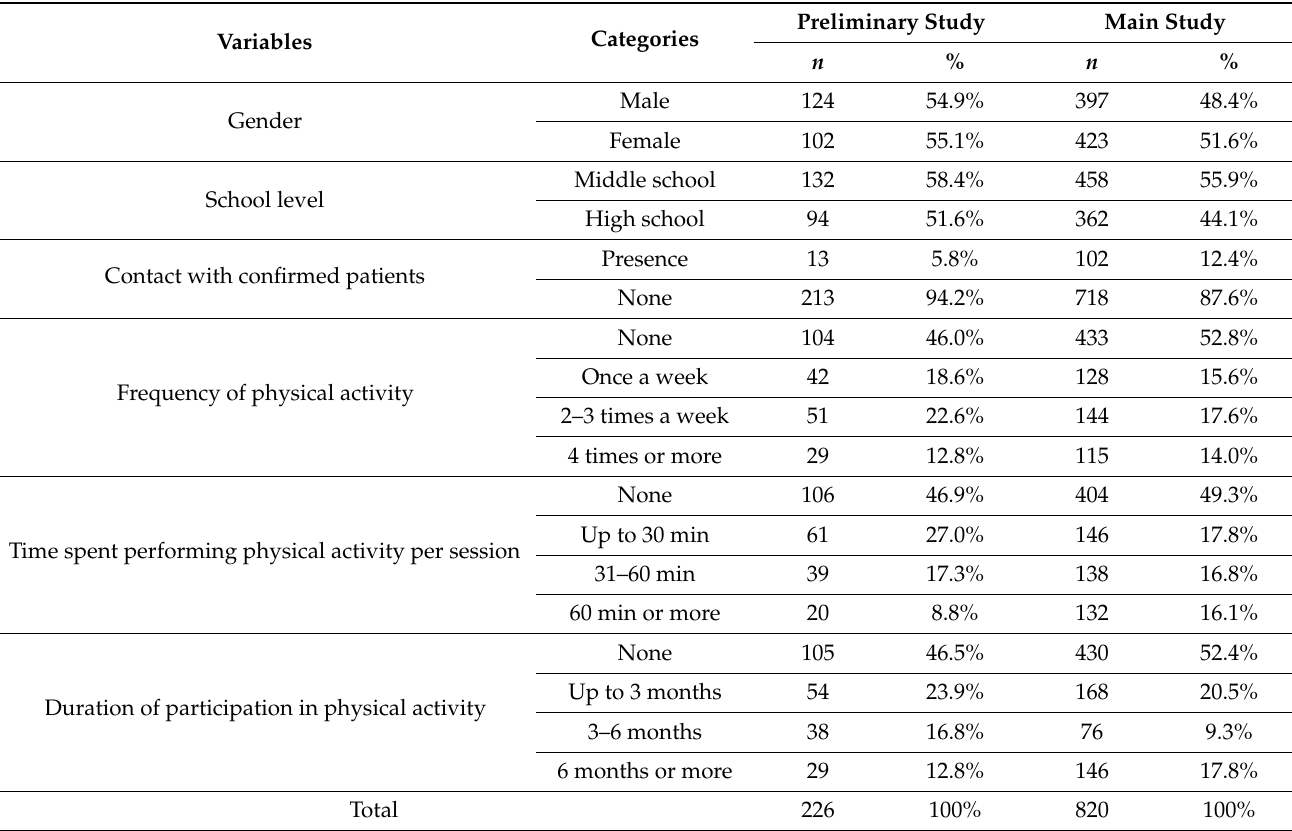
Table 1. Demographic characteristics of the